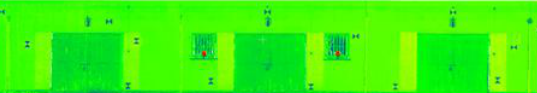
b) Figure 10. Accuracy assessment of a point cloud generated from video frames with histogram equalization with reference